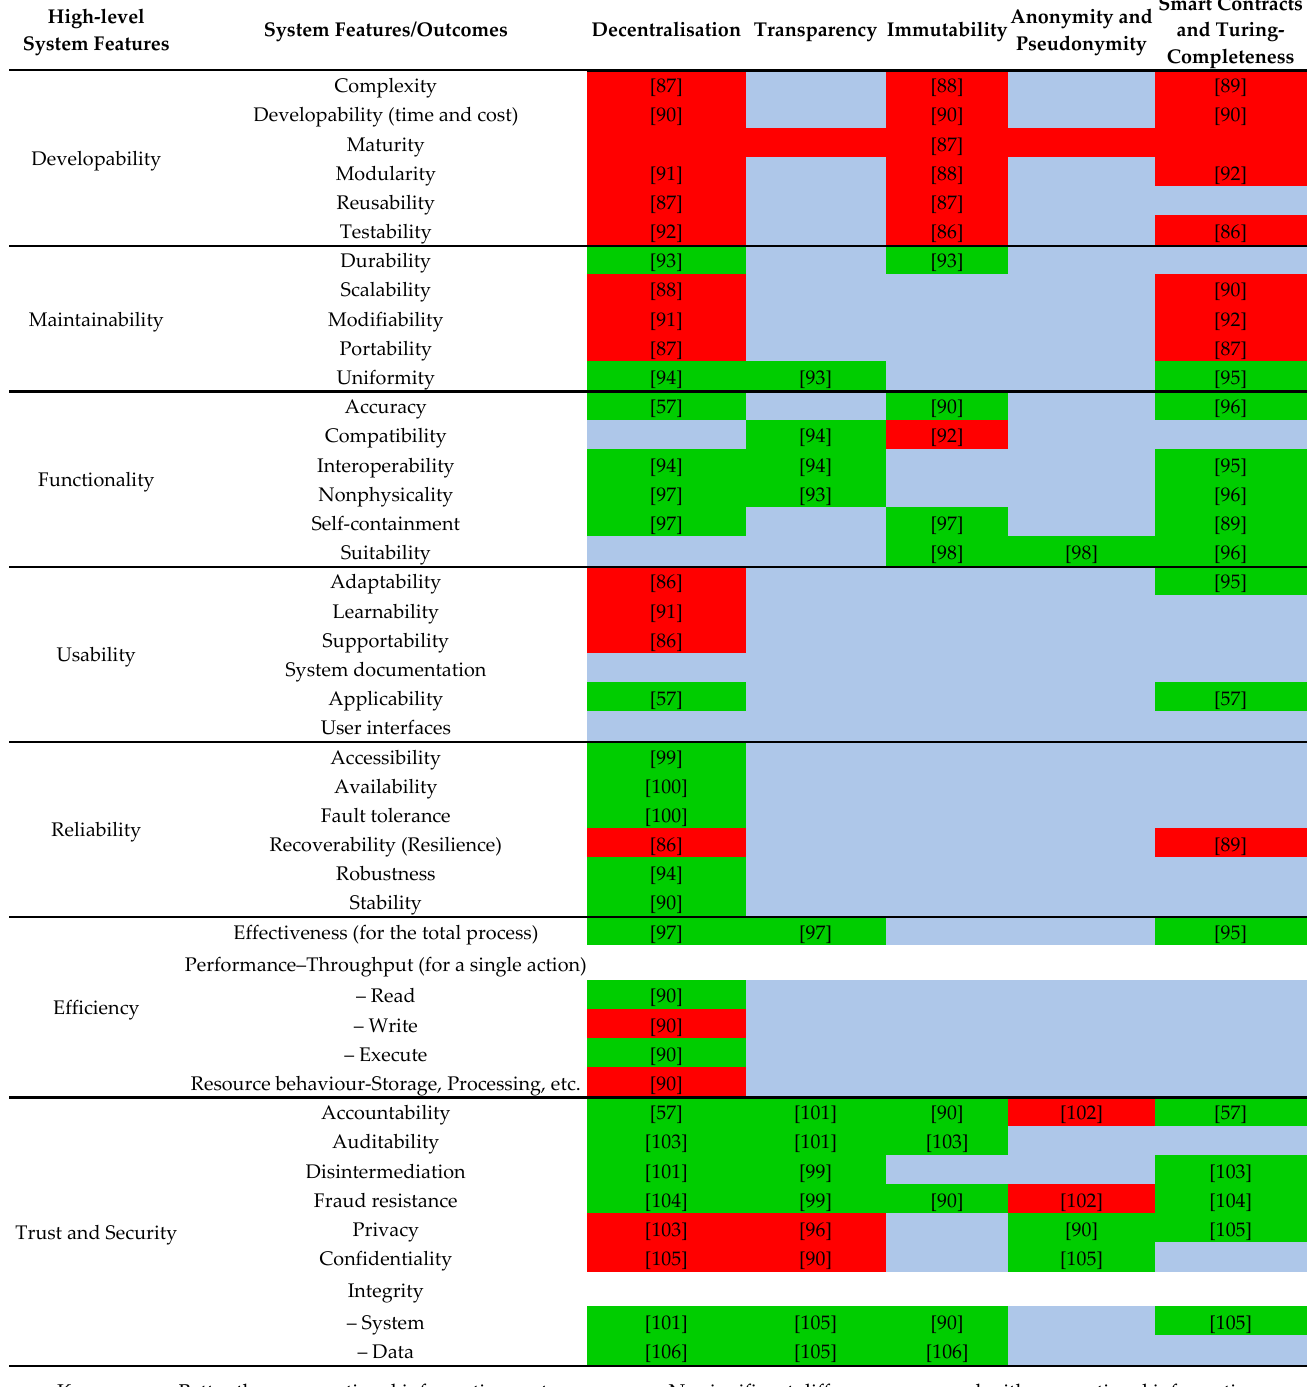
Table 1. Features of blockchain compared with conventional information systems.